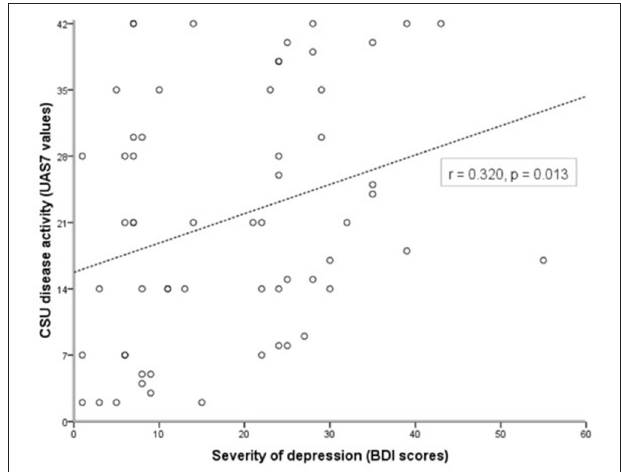
FIGURE 1 | Urticaria activity and severity of comorbid depression are linked in patients with CSU. Disease activity in CSU was assessed using the weekly urticaria activity score (UAS7, 0–42), and the severity of comorbid depression was determined using the Beck Depression Inventory (BDI, 0–63; CSU patients with BDI scores ≥ 17 were considered as CSU with comorbid depression after confirmation by a psychiatrist). Correlation analysis shows a link between higher UAS7 and higher BDI scores (r = 0.320, p = 0.013).